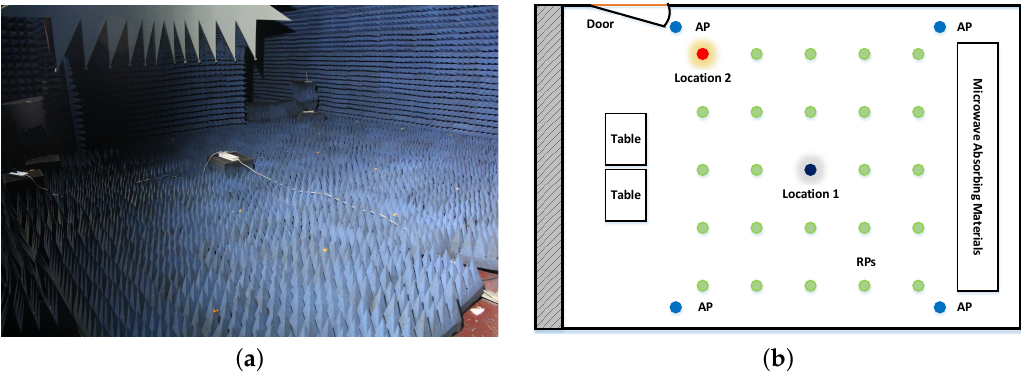
Figure 1. ( a ) Photo of the microwave anechoic chamber. ( b ) Layout of part of the microwave anechoic chamber.